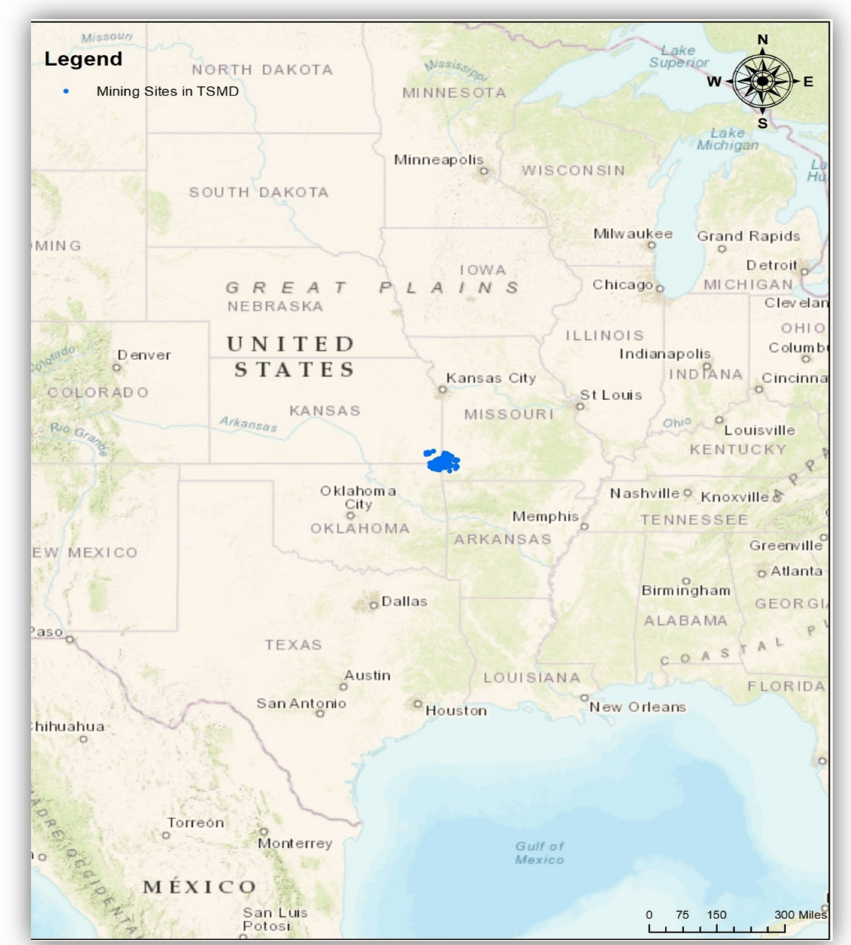
Figure 1. Locations of the Tri-State Mining District (TSMD) in the Unites States. Note: The TSMD is located in the Tri-State area (southeast Kansas, southwest Missouri, and northeast Oklahoma). Blue indicates mine-related sites including mines, mineral deposits, and mineral regions in the TSMD. The geospatial database was obtained from the U.S. Geological Survey (USGS) (Date taken: 29 July 2020). The USGS data are publicly available from https: // www.usgs.gov /